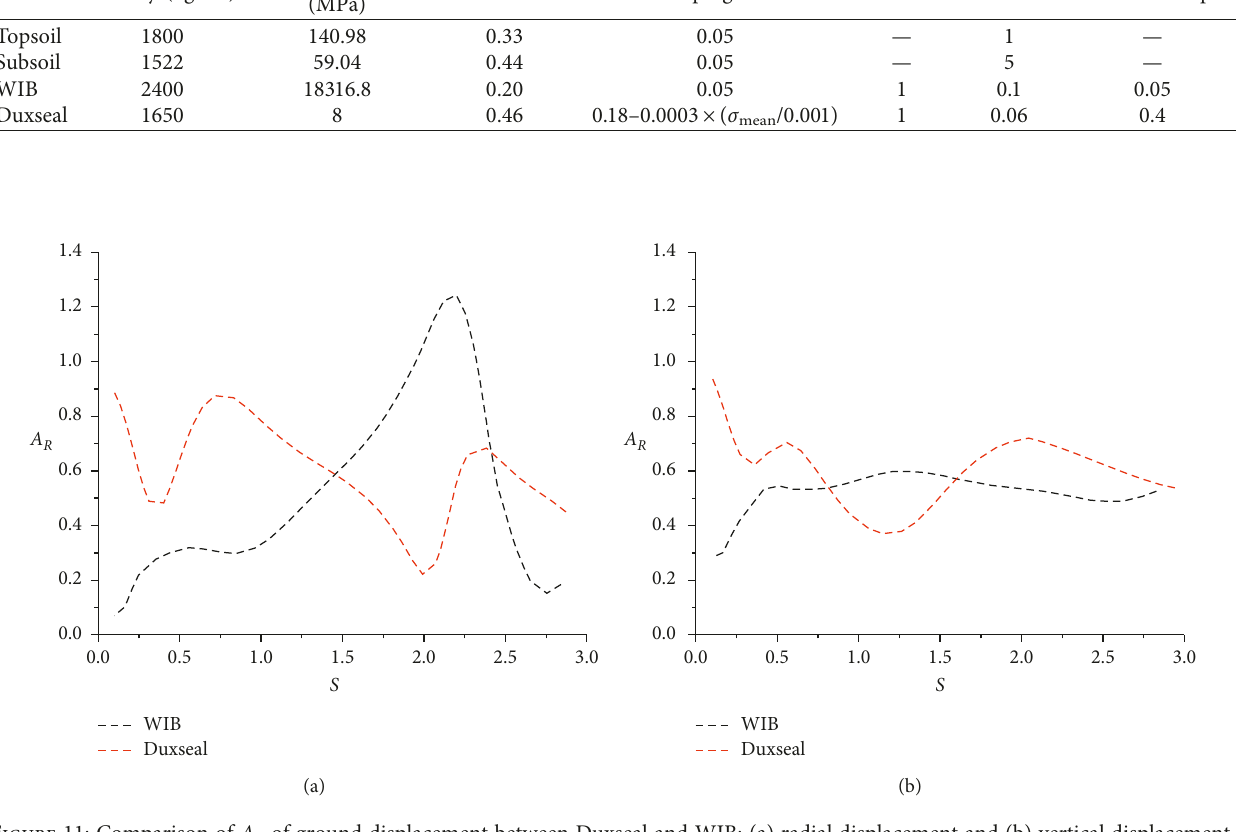
Figure 11: Comparison of A R of ground displacement between Duxseal and WIB: (a) radial displacement and (b) vertical